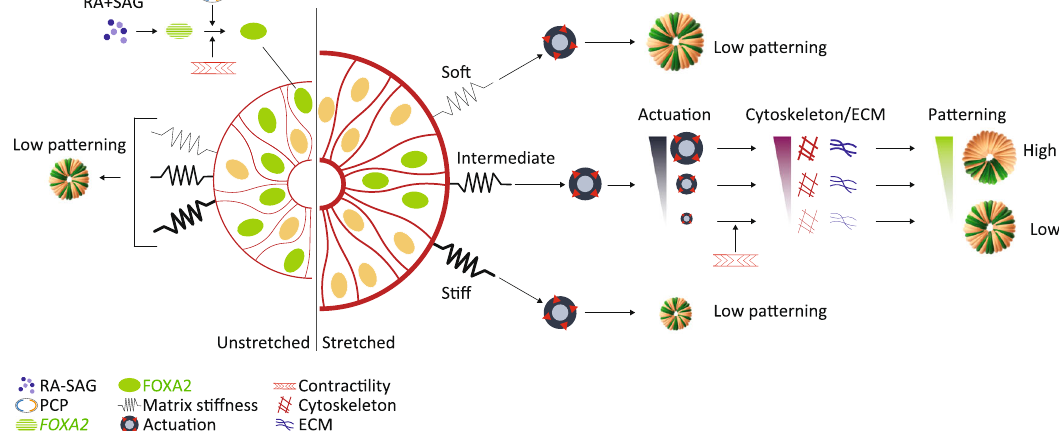
Fig. 6 Proposed model for fl oor plate induction and patterning in hNTOs. Induction of the FP requires active contractility and PCP. FP patterning enhancement relies on hNTO actuation in a matrix stiffness-dependent manner. Soft and stiff matrices result in no FP patterning enhancement upon actuation. In intermediate stiffness, actuated hNTOs exhibit higher FP patterning events linked to increased cytoskeleton and ECM remodeling